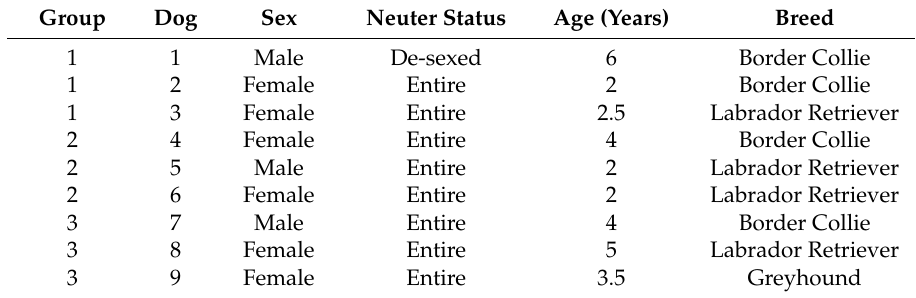
Table 1. Detection dogs used during this project. Due to their extended training time, these nine dogs were separated into three groups: March–June (Group 1), June–September (Group 2), and September–November 2017 (Group